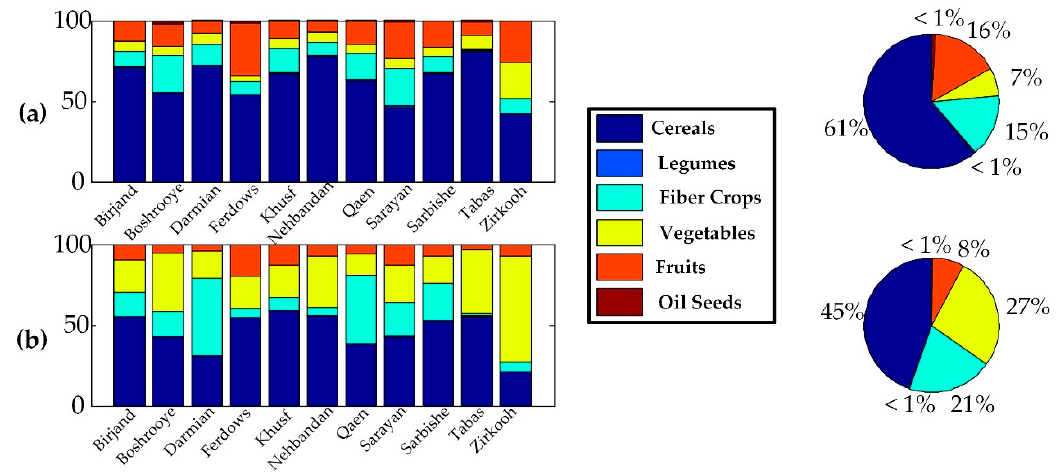
Figure 4. ( a ) The state of cultivation area, and ( b ) the crop production in each Figure 4. (a) The state of cultivation area, and (b) the crop production in each county.